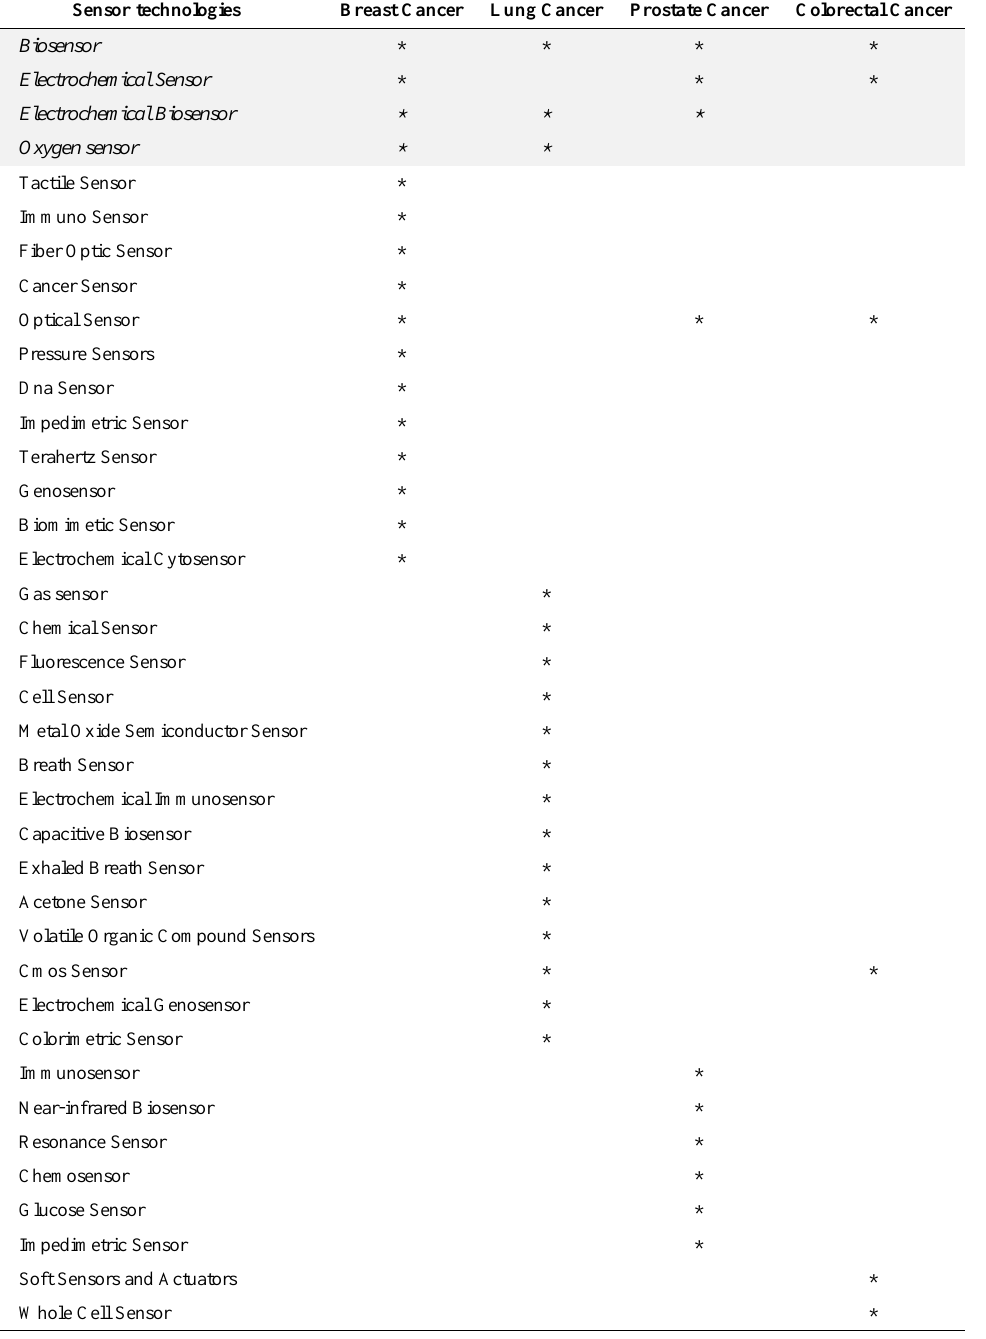
Table 2. The most frequent sensors in cancer studies Sensor technologies Breast Cancer Lung Cancer Prostate Cancer Colorectal